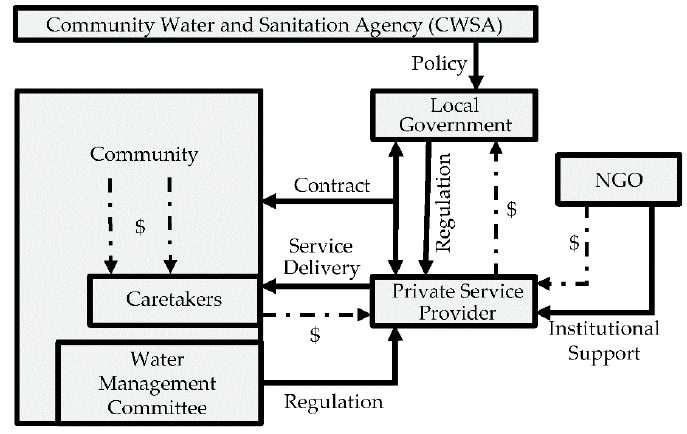
Figure 1. Service provider institutional framework.